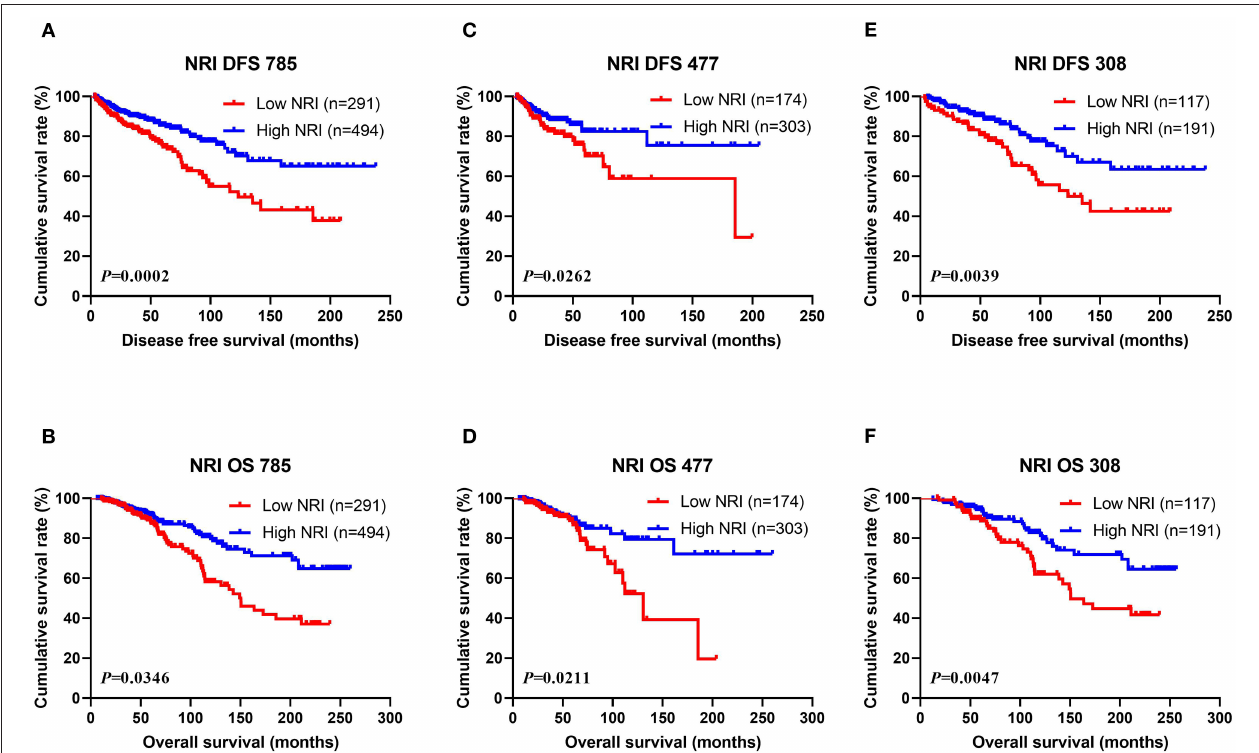
FIGURE 1 | DFS and OS of patients with breast cancer. (A) Kaplan-Meier analysis of DFS for the NRI of all breast cancer patients. (B) Kaplan-Meier analysis of OS for the NRI of all breast cancer patients. (C) Kaplan-Meier analysis of DFS for the NRI of breast cancer patients in NACT group. (D) Kaplan-Meier analysis of OS for the NRI of breast cancer patients in NACT group. (E) Kaplan-Meier analysis of DFS for the NRI of breast cancer patients in non-NACT group. (F) Kaplan-Meier analysis of OS for the NRI of breast cancer patients in non-NACT group.